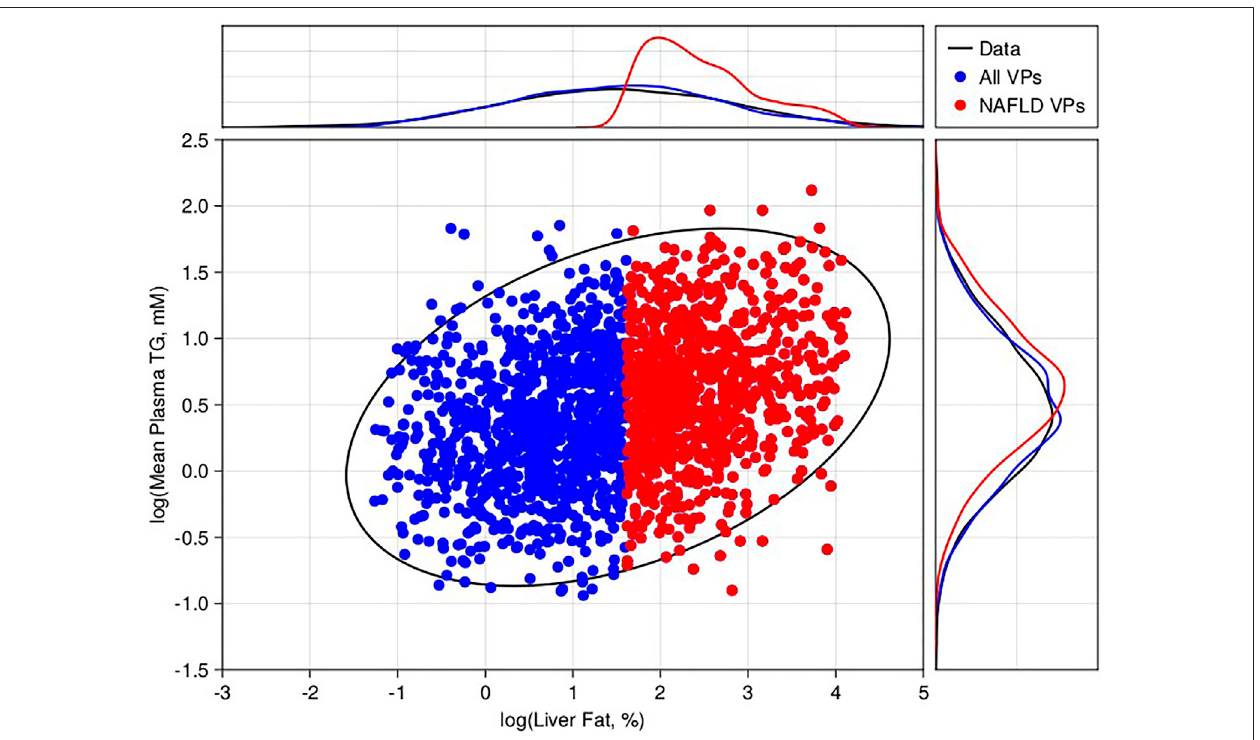
FIGURE 2| Virtual population selection with comparison toliterature-derived constraints. 2D scatter compares the steady state 24-h average plasma triglycerides versus liver fat % for 2,000 selected virtual patients (blue — non-NAFLD, red — NAFLD). For comparison, we calculated the 95% con fi dence interval of the 2D-lognormal distributionderivedfrom literature (black ellipse).Themarginaldistributionsforthevirtualpatients(blueand redlines)forliverfat %(top) and plasmatriglycerides(top)are also shown versus the data (black lines).